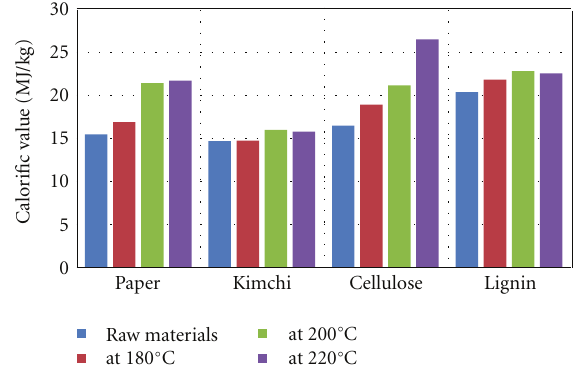
Figure 4: E ff ect of the hydrothermal treatment on the calorific value of products.